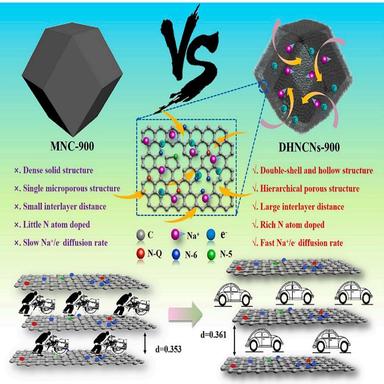
Schematic illustration for the unique feature of DHNCNs-900 as anode material in SIBs.